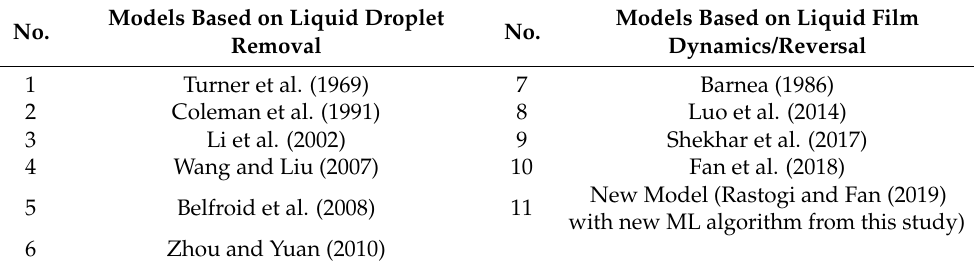
Table 2. Start-of-the-art droplet and film reversal-based modeling studies for critical gas velocity estimation.